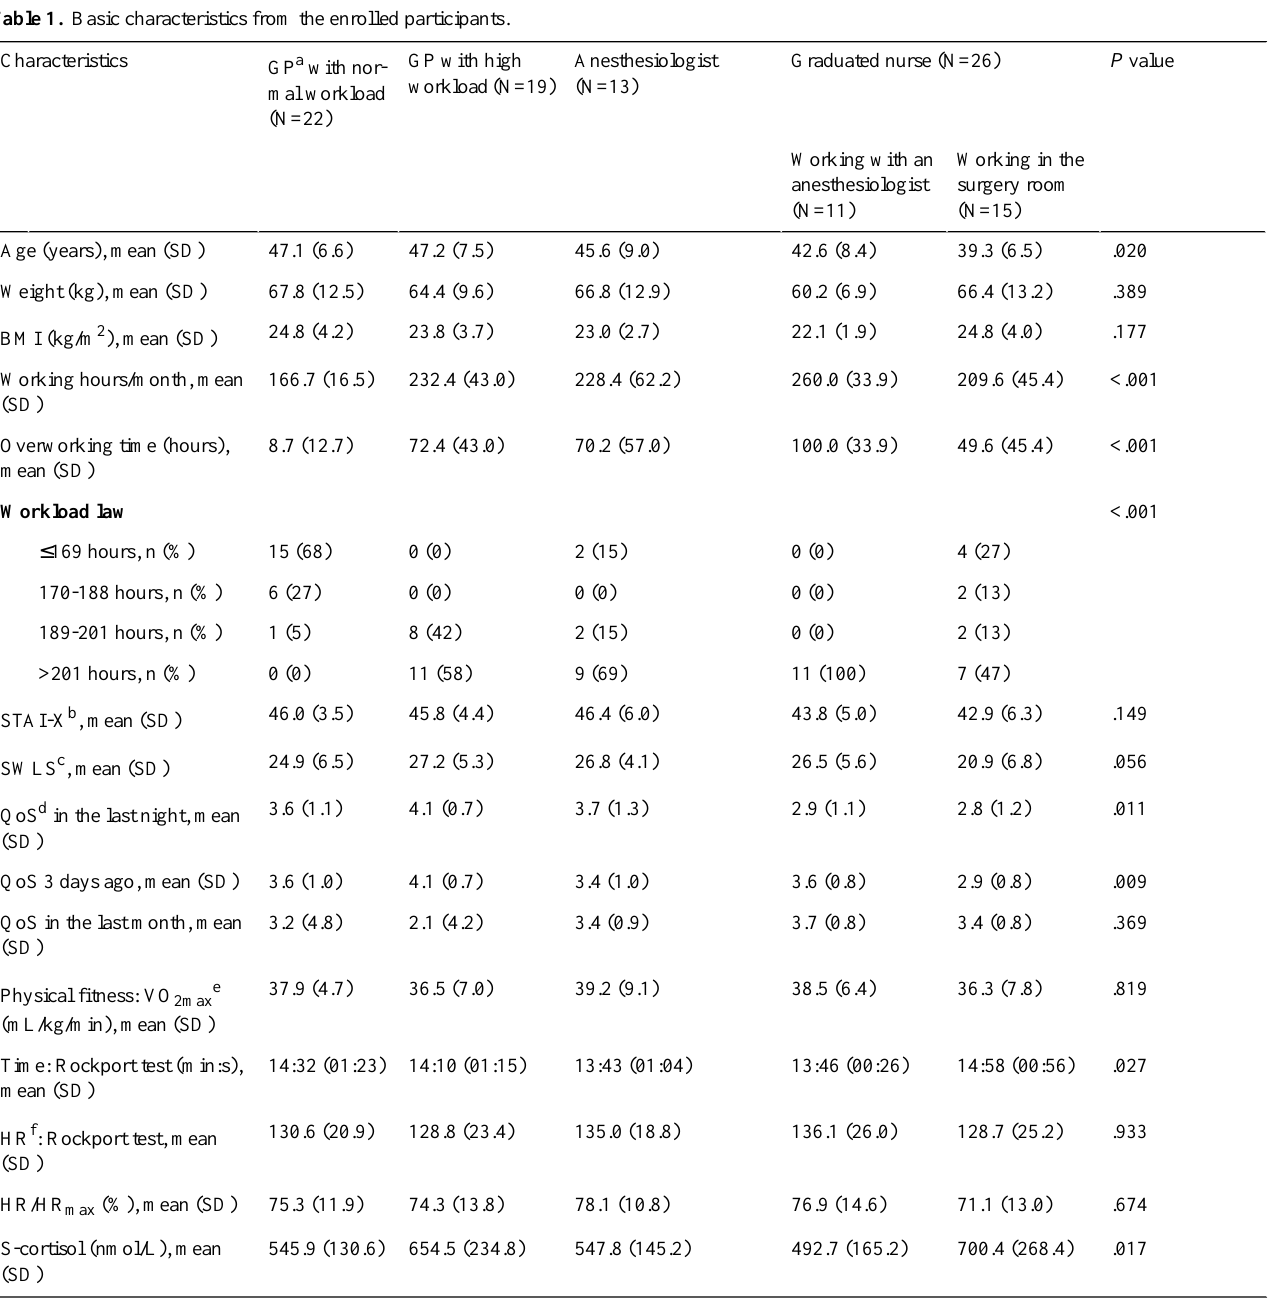
Table 1. Basic characteristics from the enrolled participants.